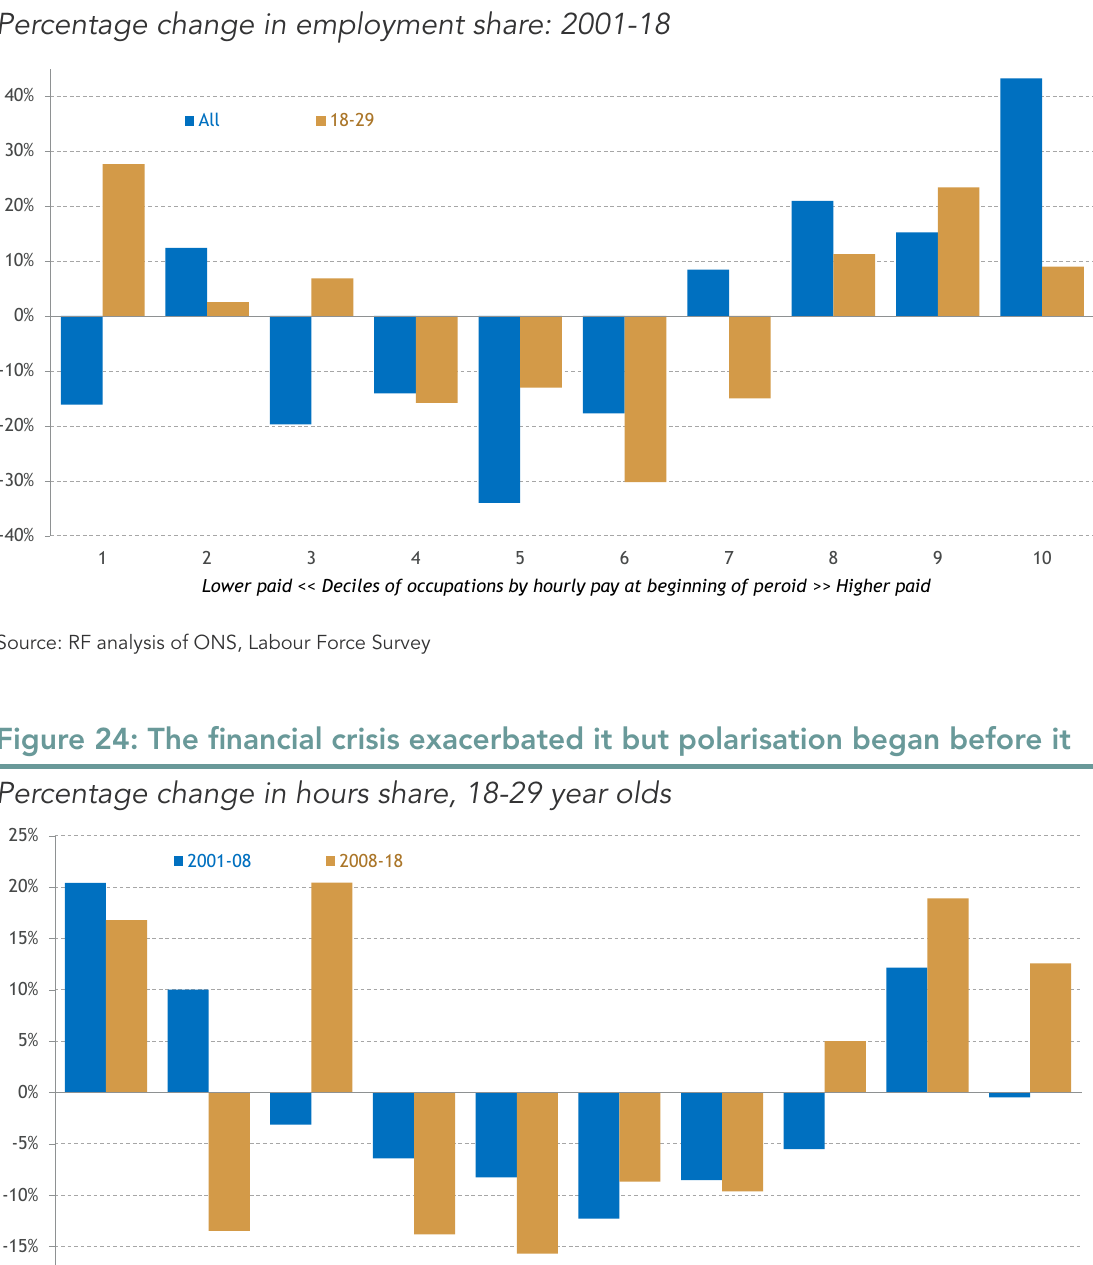
Figure 23: There is clear evidence of occupational polarisation for younger workers